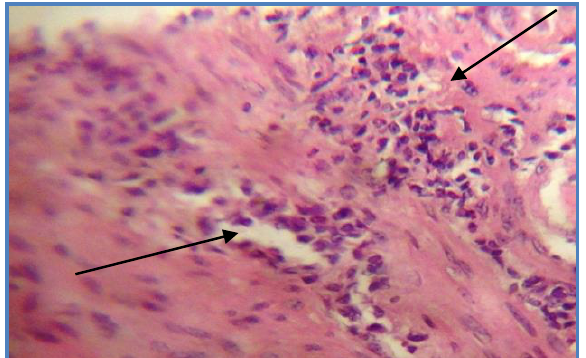
Figure, 7: Intestine of mice at 10 days post infecttion by Candida albicans and treated with Datura stramonium extract 10% ( ) shows infiltration of inflammatory cell mainly neutrophils and MNCs in the submucosa and the muscularis mucosa (Heamatoxcyline and Eosin stain 40X).